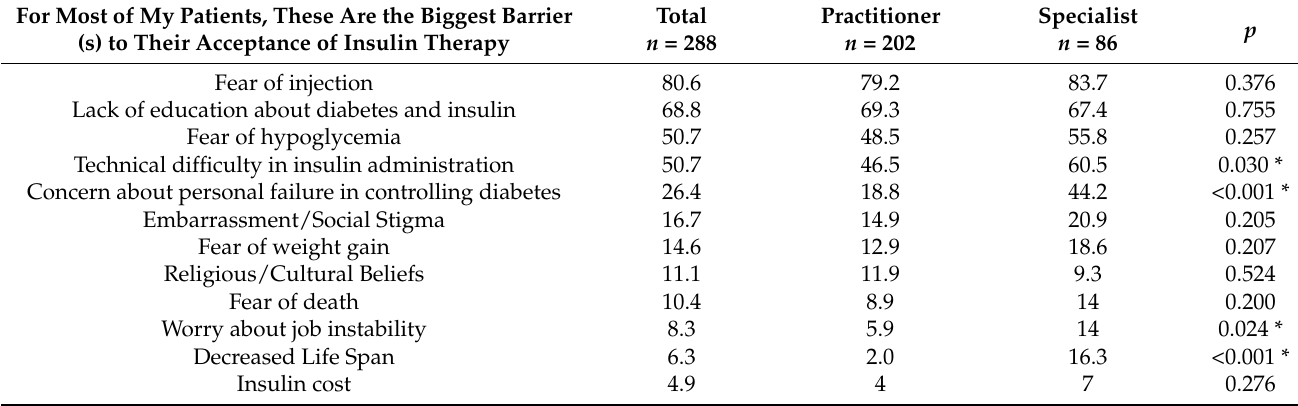
Table 1. Primary care physician perceived barriers to insulin therapy.